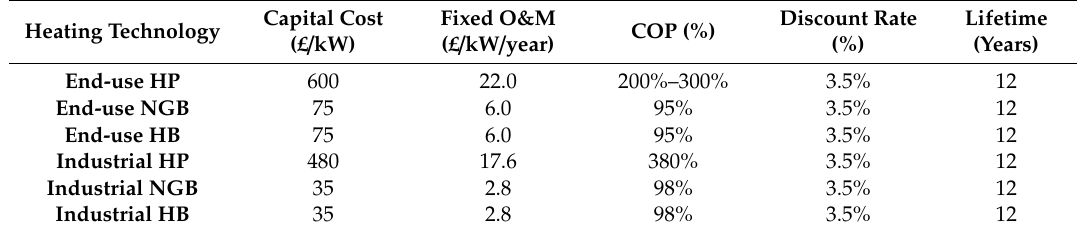
Table 2. Economic and operational parameters of the heating technologies.